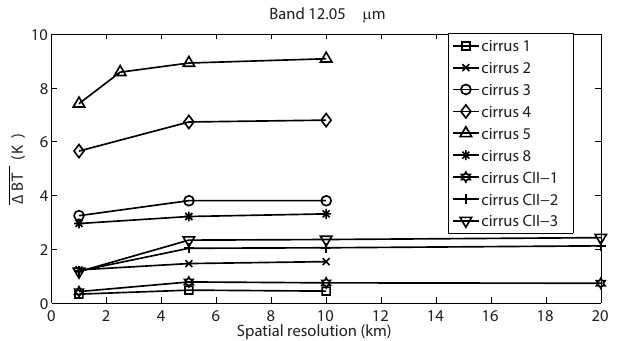
Figure 18. Brightness temperature differences 1 BT at 12 . 05µm as a function of the spatial resolution for different cirri.